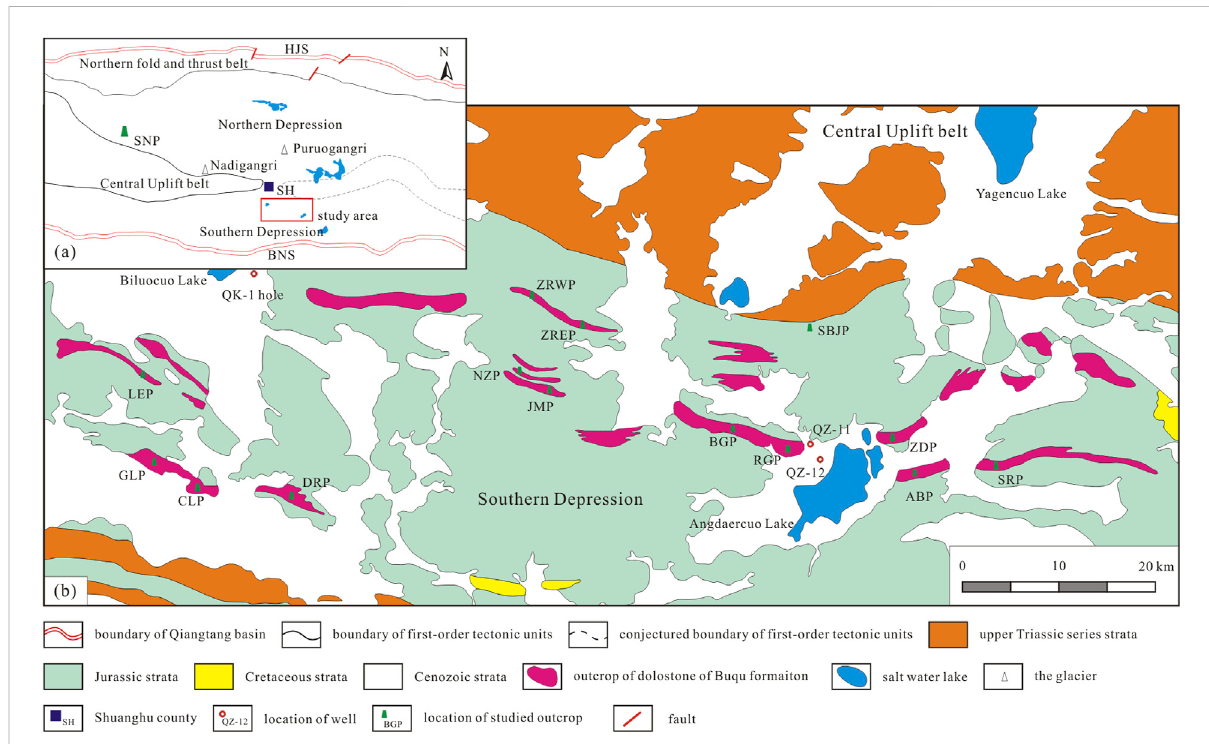
FIGURE 1 Tectonic location of the Qiangtang Basin (A) , and distribution and well location of the Buqu Formation dolostone section assessed in the study area (B) ( (A) modi fi ed from Wan et al., 2018a (B) modi fi ed from Ji et al., 2020). Buqu Formation dolostone section: SNP, Suonahu lake section; SBJP, Saibangji section; LEP, Long ’ eni section; GLP, Geluguanna section; CLP, Chalai section; NZP, Nianzha section; JMP, Jiamu ’ erqie section; ZRWP, Zharen west section; ZREP, Zharen east section; BGP, Bagedijiari section; RGP, Riga ’ erbao section; ZDP, Zhadonglaima section; ABP, Angbacundong section; SRP, Sairen